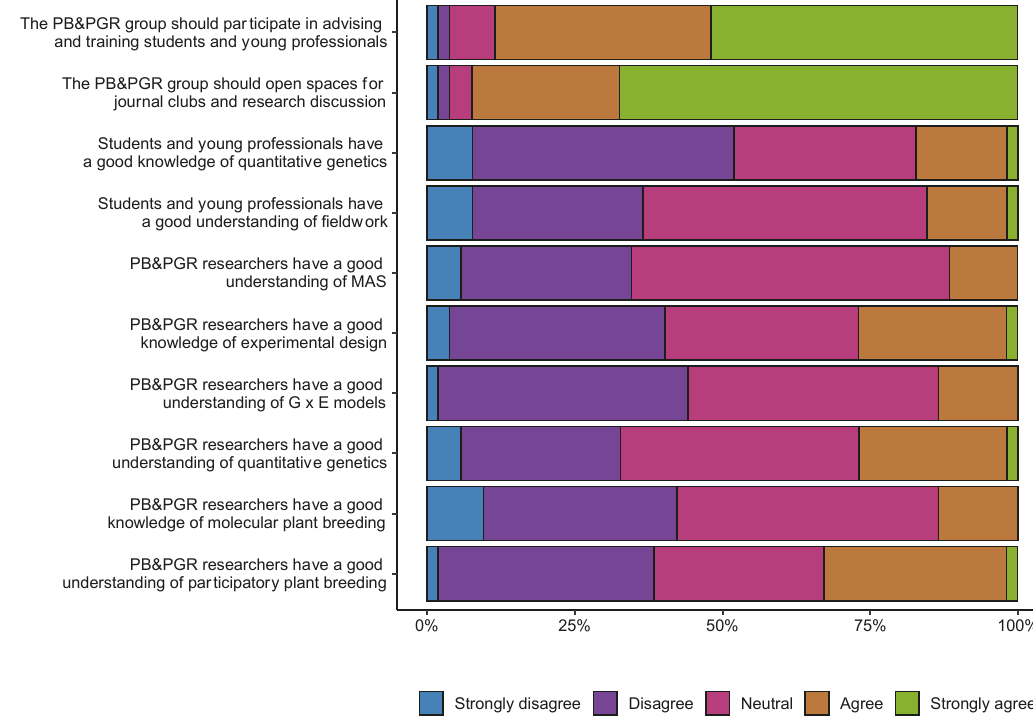
Figure 6. List of ten statements on challenges and opportunities associated with research in plant breeding and plant genetic resources within A GROSAVIA . The color bars represent the opinion of the 52 researchers surveyed, indicating in percentage the number of researchers who responded with each level of agreement for each statement. The categories from left to right are: strongly disagree, disagree, neutral, agree, strongly agree.